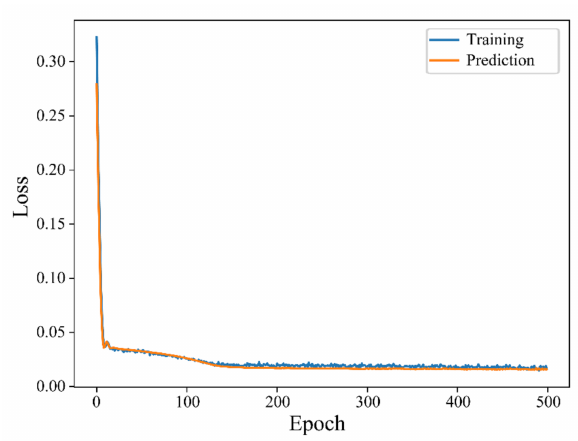
Figure 8. Predicted stern acceleration.